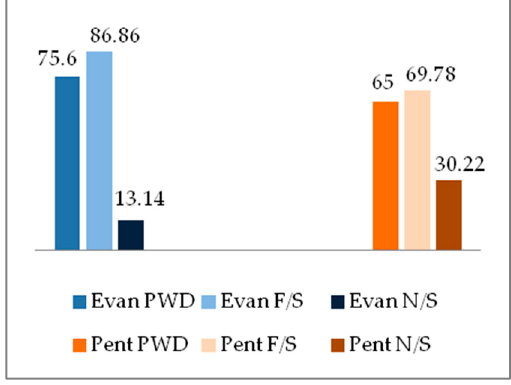
Figure 4. Care for the Beraved Overall Average % Denominational Shift Figure 5 The Caregiver : Six statements intended to ascertain the openness of caregivers to engage